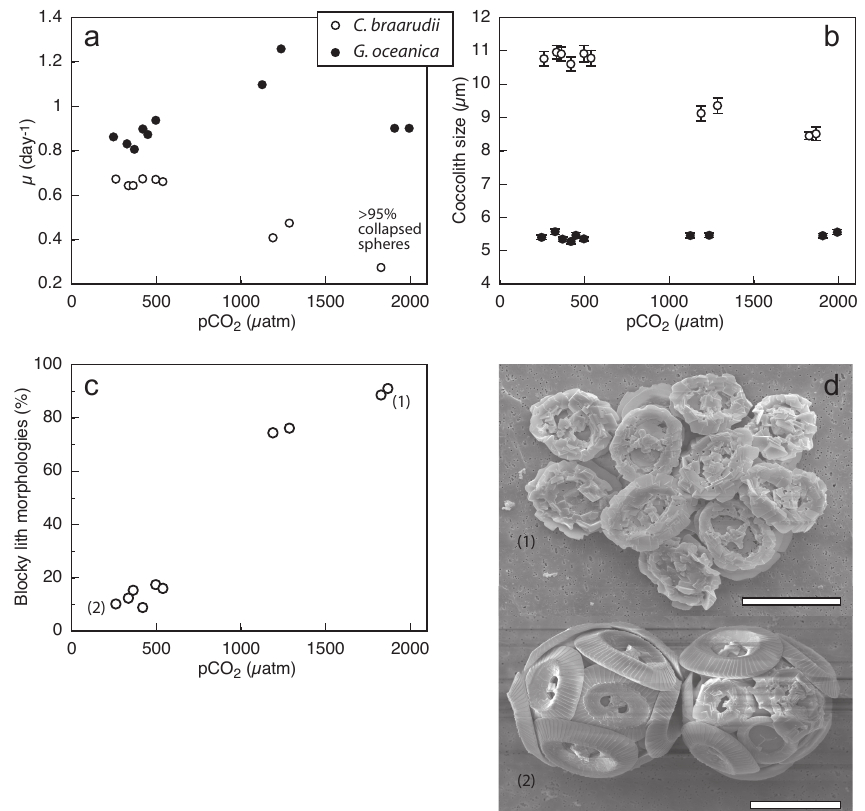
Fig. 2. (a) Growth rates ( µ , day − 1 ) and (b) coccolith size for G. oceanica (black circles) and C. braarudii (open circles) with correlated and increasing DIC, CO 2 − , and p CO 2 . Under the high DIC conditions, C. braarudii was severely detrimentally affected (c) showing signs 3 of significant malformation as shown by comparison under the SEM (d) and > 95% of the coccospheres were collapsed at the highest DIC Figure 2 treatment. The scale bars indicate